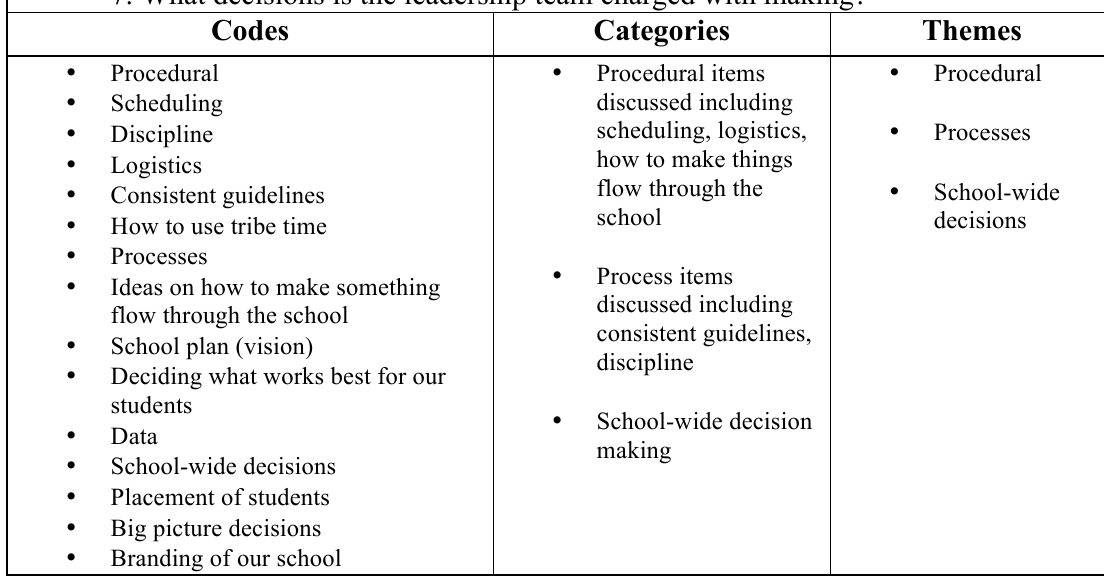
Leadership Team Members’ Question Seven and Coding 7. What decisions is the leadership team charged with